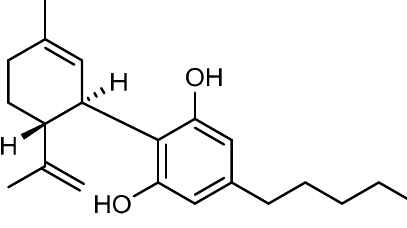
Figure 1. Chemical structure of cannabidiol .